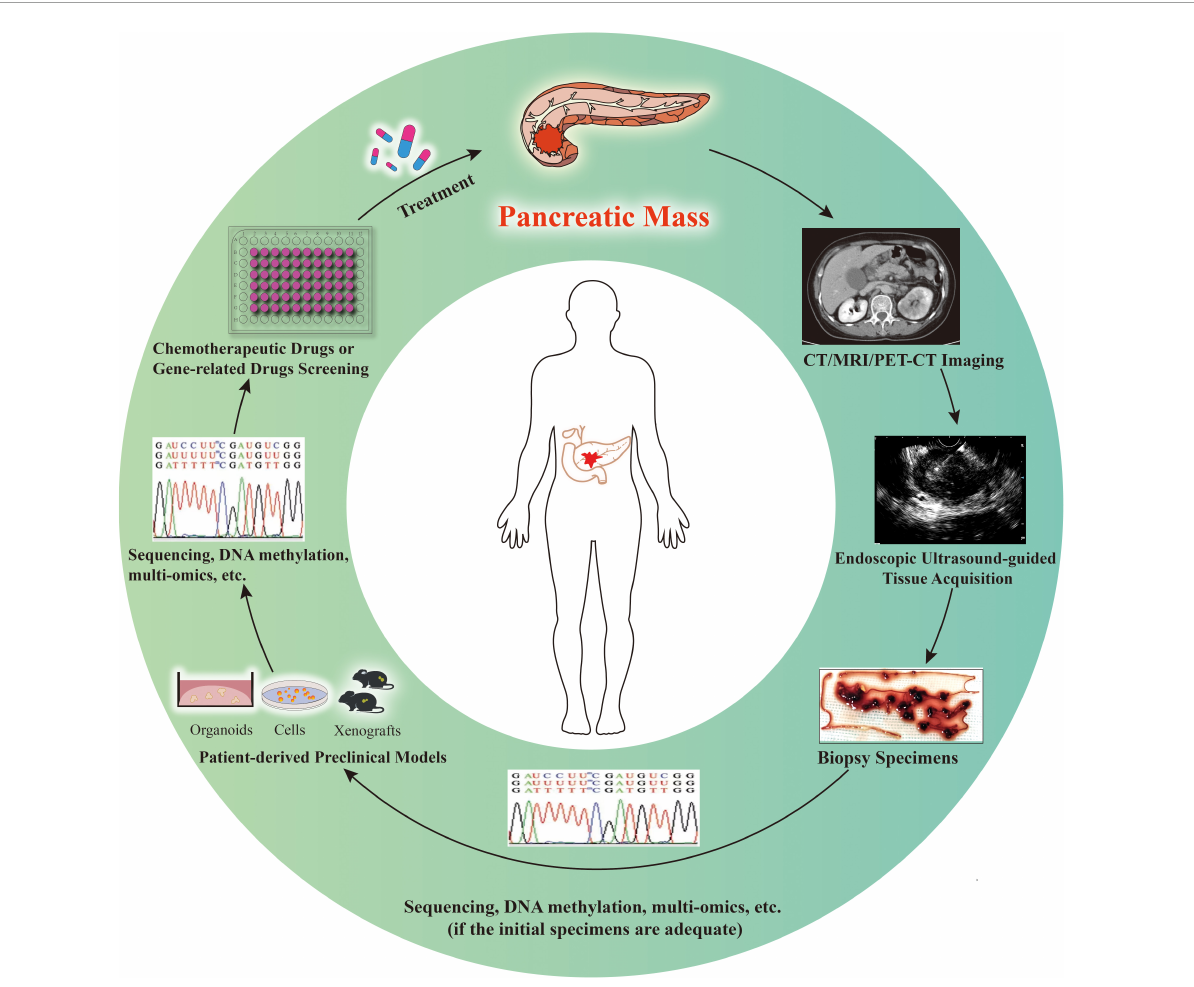
FIGURE1 Patient-derived preclinical models for individualized cancer therapy. In the case of imaging highly suspect of pancreatic malignancy, endoscopic ultrasound-guided tissue acquisition is performed to achieve diagnosis and obtain specimens to determine individualized treatment options. If the specimens are adequate for sequencing, DNA methylation, multi-omics, or other molecular studies, as well as construction of preclinical models, studies and model construction can be conducted simultaneously (relatively rare). Otherwise, the models are established first and then various studies are conducted (relatively common). The patient-derived preclinical models might be used for drug screening and/or verification, as well as diverse studies. With the progress of individualized treatment, clinicians will decide whether longitudinal sampling is needed and whether the above process needs to be repeated according to the treatment effect of